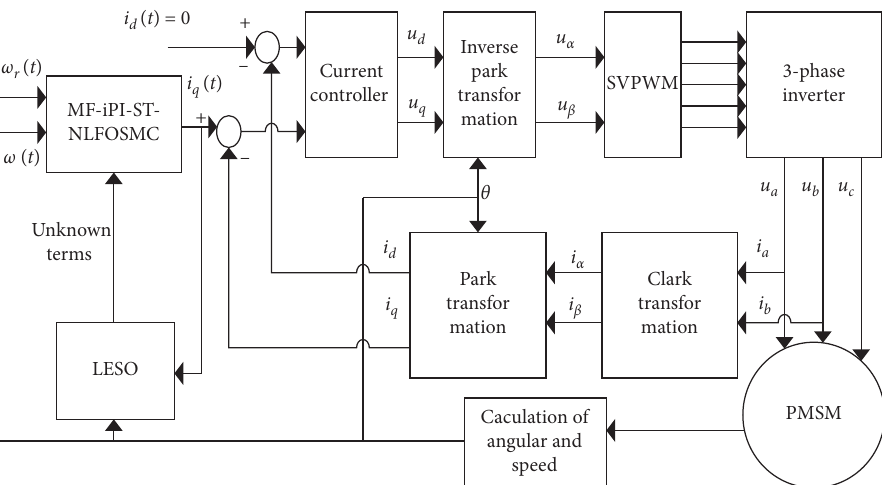
Figure 2: The configuration of the novel field-oriented control of PMSM speed regulation system based on the proposed MF-iPI-ST- NLFOSMC strategy.